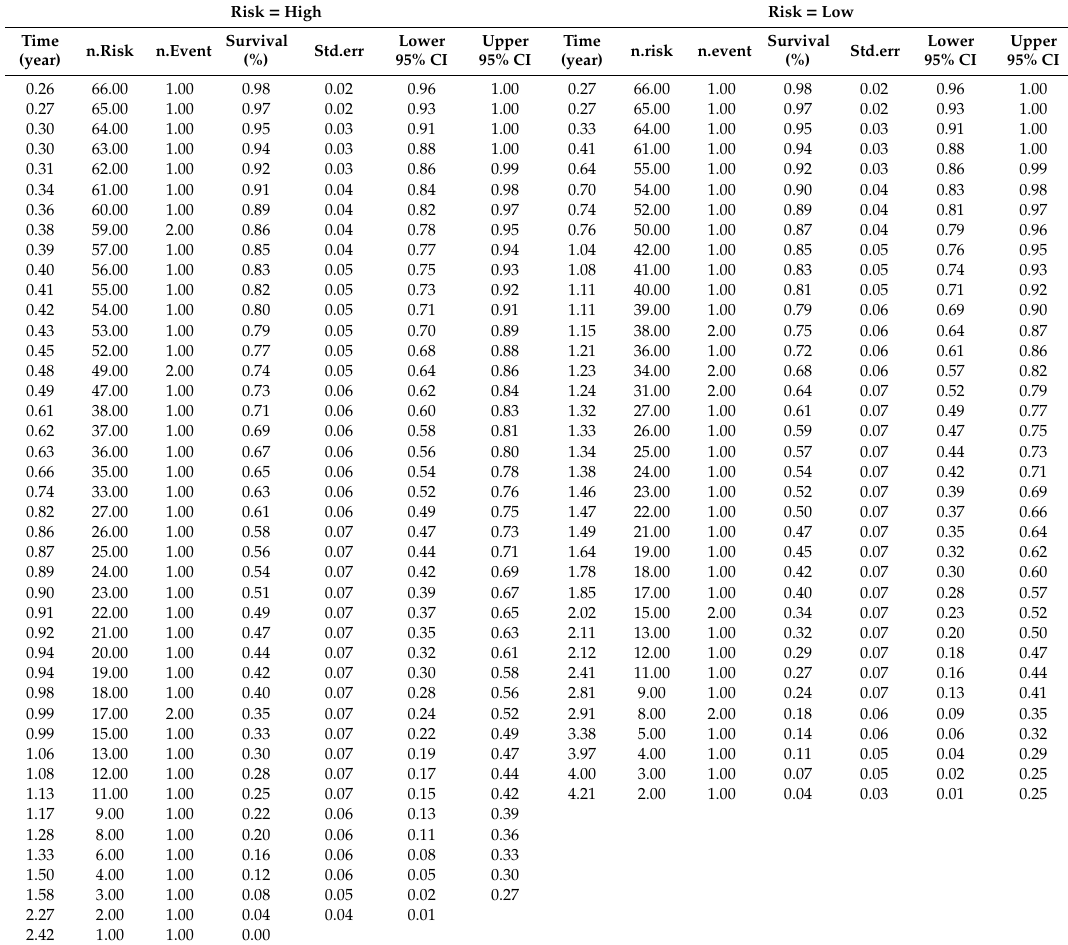
Table 3. The survival rates of high-risk and low-risk patients. Detailed survival rate corresponding to each time point.